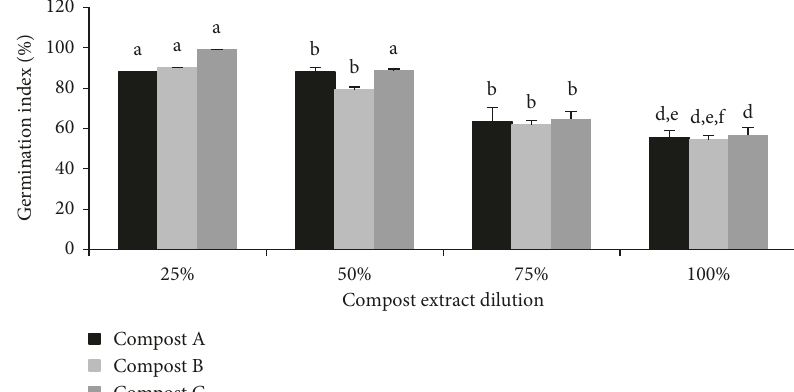
Figure 6: Effect of the compost extract on germination of cress seeds at different dilutions ( n � 5, p � 0 . 05). Different letters (a–f) indicate significant differences ( p < 0 . 05) between compost and dilution rates.